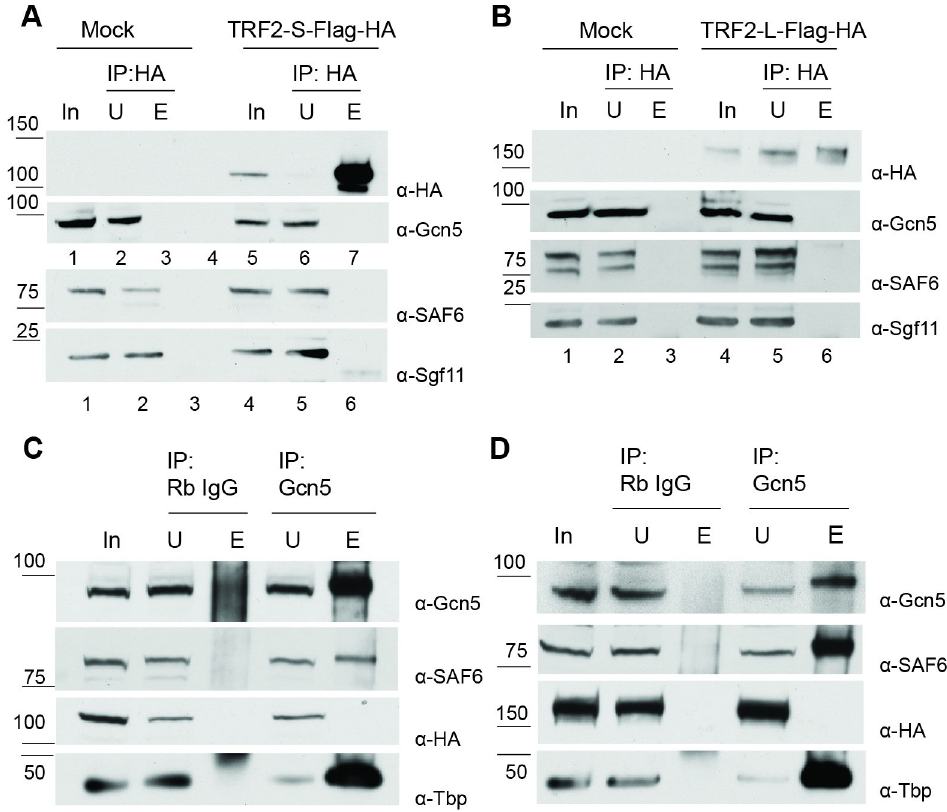
Fig 6. SAGA and affinity-tagged TRF2 isoforms do not stably interact in S2 cells. (A) Reciprocal coimmunoprecipitation after transient transfection with pAcTRF2-S-Flag-HA. Using rat anti-HA to immunoprecipitated TRF2-S-Flag-HA, SAGA did not coimmunoprecipitate. (B) Reciprocal coimmunoprecipitation after transient transfection with pAcTRF2-L-Flag-HA. Using rat anti-HA to immunoprecipitated TRF2-L-Flag-HA, SAGA did not coimmunoprecipitate. (C) Coimmunoprecipitation after transient transfection with pAcTRF2-S-Flag- HA. Using Gcn5 as a bait, affinity-tagged TRF2-S does not coimmunoprecipitate. (D) Coimmunoprecipitation after transient transfection with pAcTRF2-L-Flag-HA. Using Gcn5 as a bait, affinity-tagged TRF2-L does not coimmunoprecipitate. In: unbut U: unbout E: eluate.